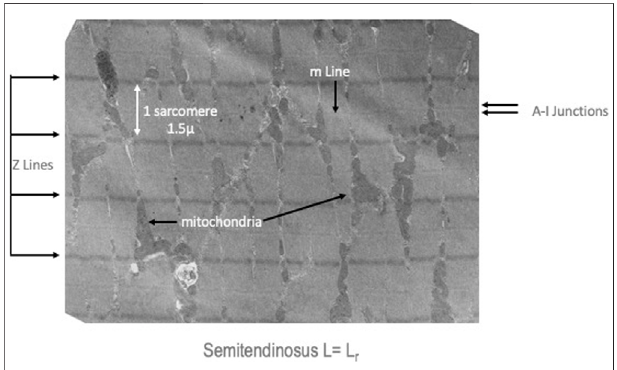
FIGURE3| Mediumresolutionelectronmicrographofasemitendinosus muscle at L r . The Z lines which demonstrate the distance between sarcomeres, the A-I junctions which are the region where the sarcoplasmic reticulum and t-tubules (invaginations of the surface membrane to make excitationcontractioncouplingmoreuniform)arelocatedandindicatorsofthe many mitochondria in these high oxidative